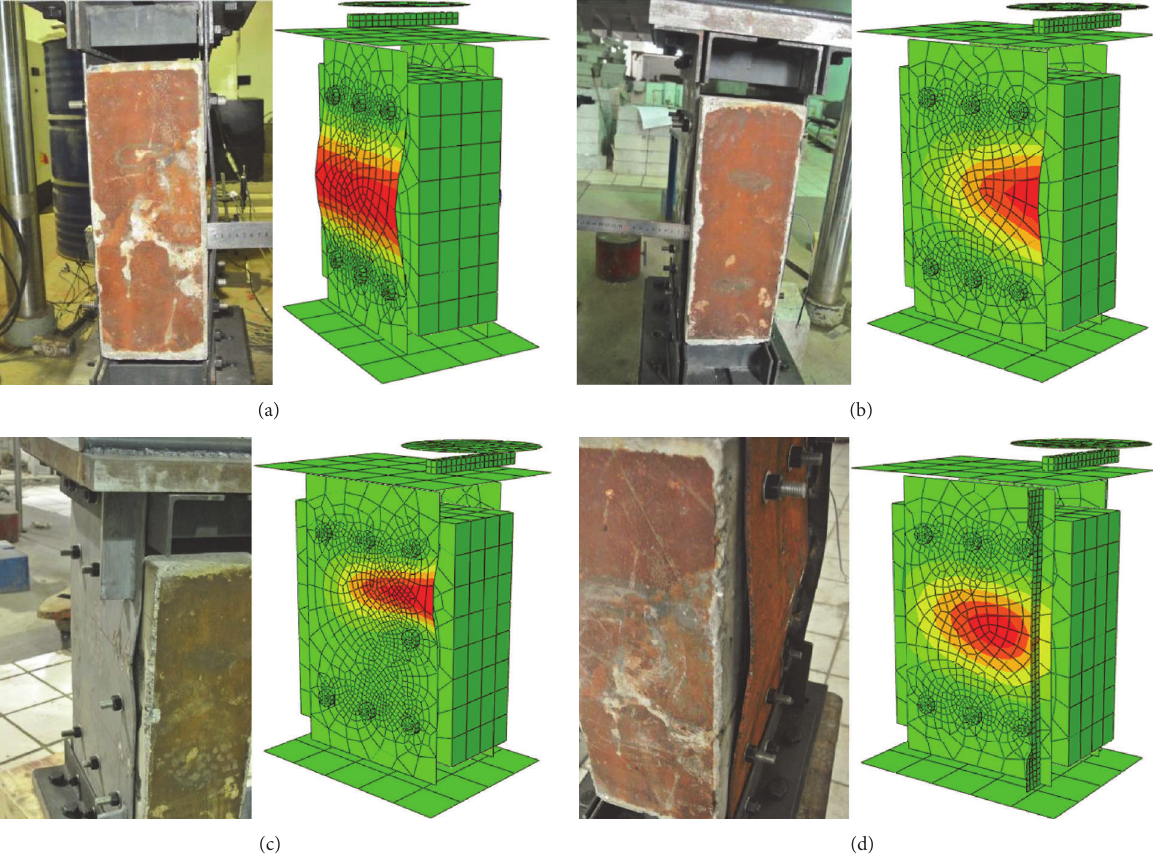
Figure 5: Experimental and simulative failure modes: (a) C4NN, (b) E6NN, (c) E4AN, and (d) E4MN.